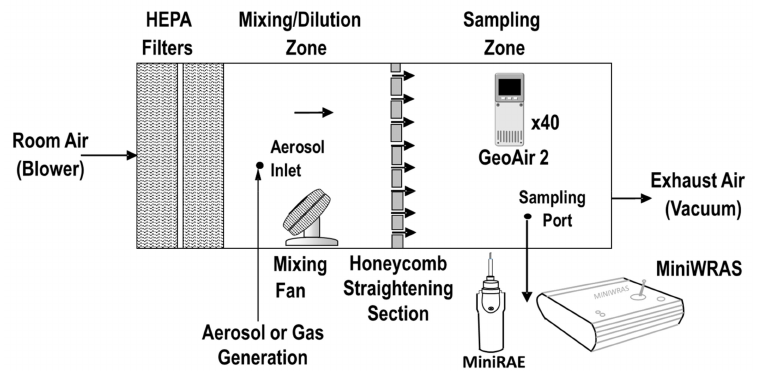
Figure 3. Experimental setup used to test the GeoAir functionality and response for aerosol and